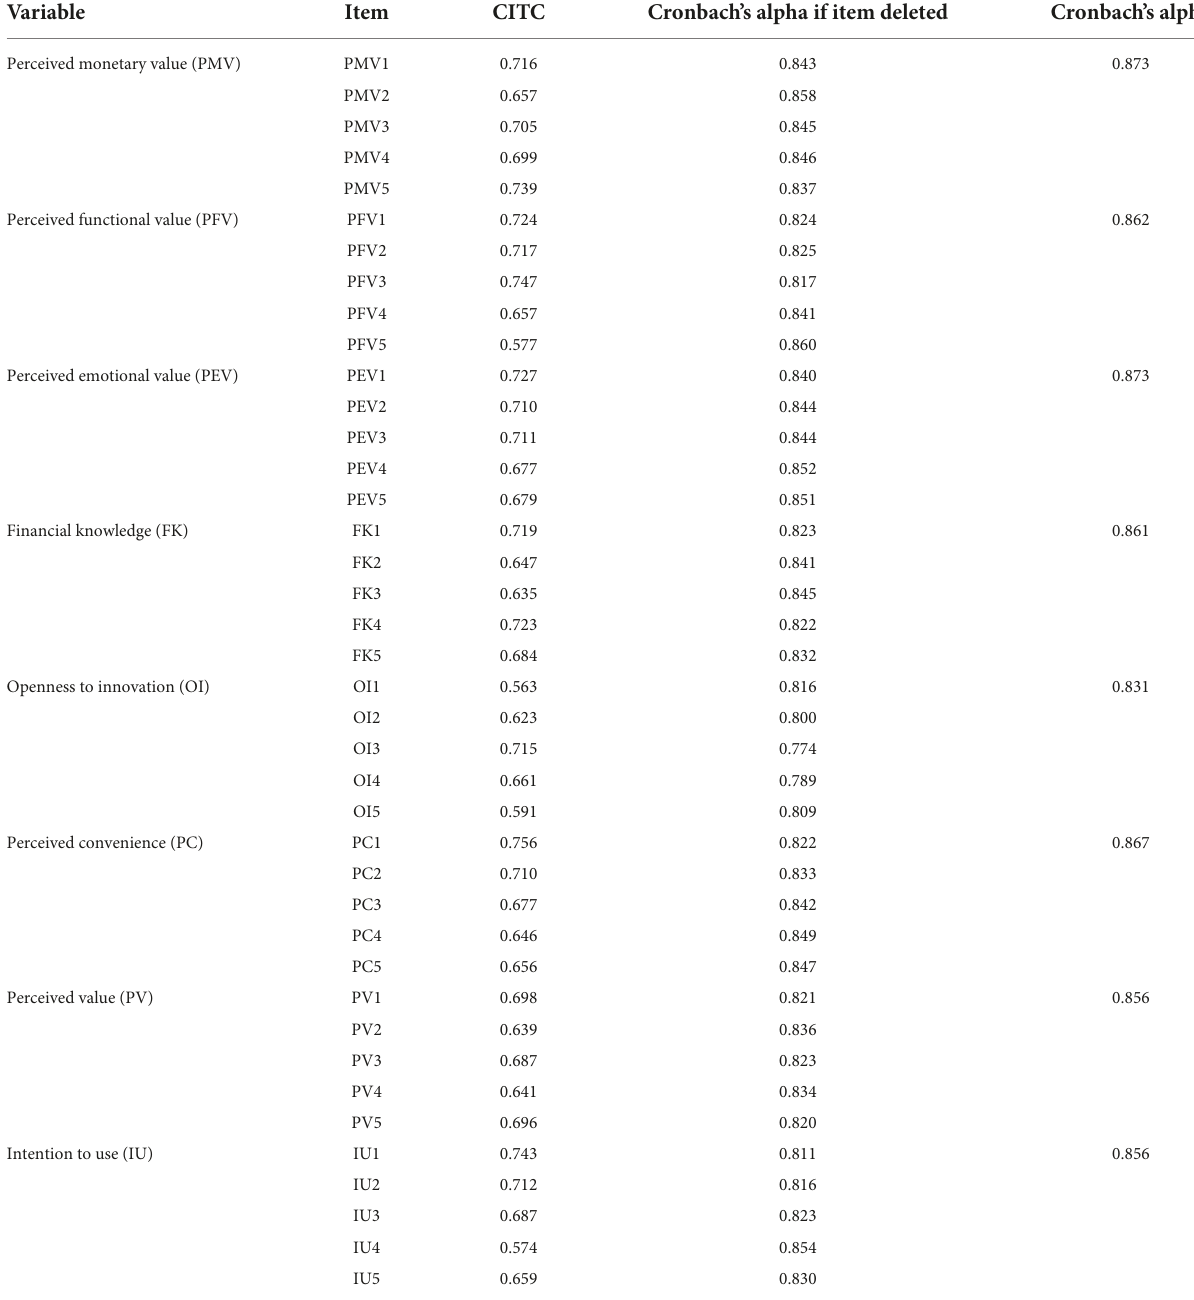
TABLE 1 Results of the Cronbach’s alpha